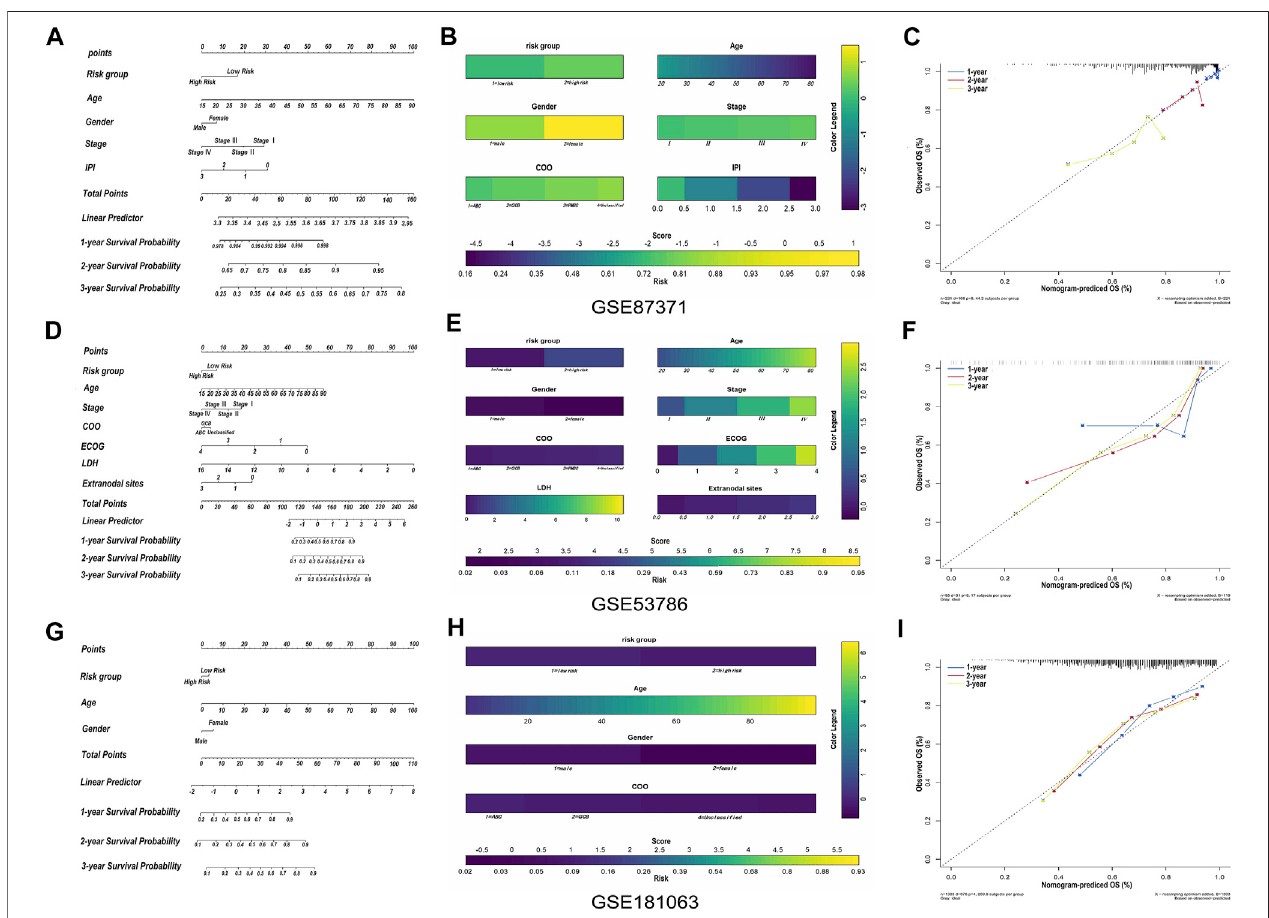
FIGURE8| Theconstructionandvalidationofnomogram. (A) PrognosticnomogramforpredictingthesurvivalofGSE87371DLBCLpatientsandeveryprediction factor relevant to total score. Clinically, the corresponding score can be obtained according to every patient ’ s condition, and the total score corresponds to every patient ’ scorrelatedsurvivalprobability. (B) Colornomogram,colorlegendontherightcorrespondstothescoreofdifferentvariablesofeveryGSE87371DLBCLpatient. The scores of multiple variables are added to the bottom total score, with corresponding survival probability. (C) Calibration curves of the nomogram predicts the GSE87371 patents ’ survival probability at 1-, 2- and 3-year. If the actual curve is closer to the ideal curve, the nomogram predication accuracy is higher. (D – F) Nomogram and calibration diagram of validation set GSE53786. (G – I) Nomogram and calibration diagram of validation set